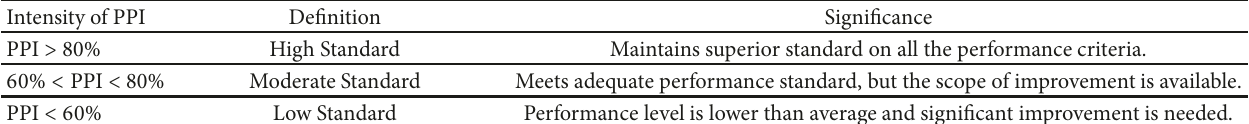
Table 2: Inland port performance index